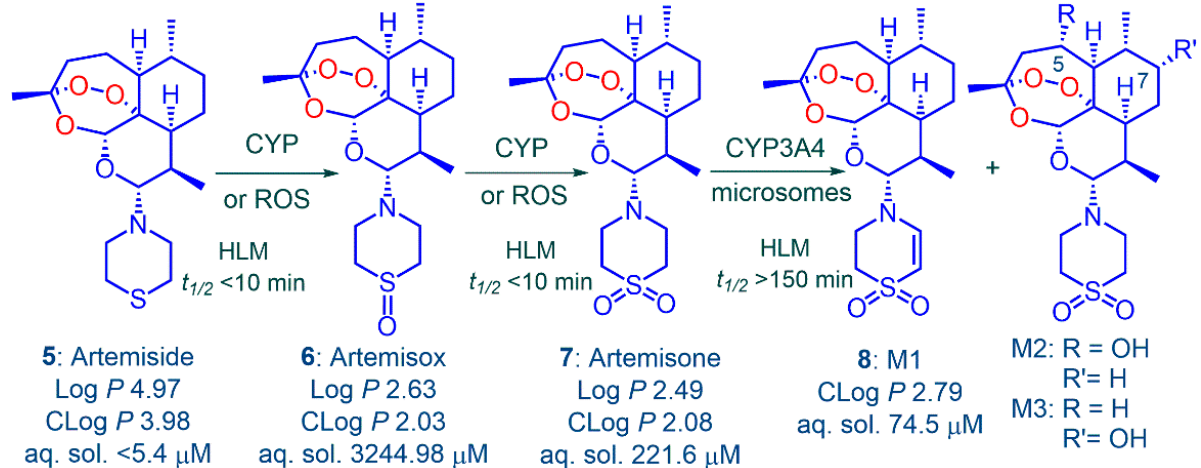
Figure 5. Metabolism of artemiside 5 via enzymatic or non-enzymatic oxidation to artemisox 6 and then to artemisone 7 . Human liver microsomal (HLM) half-lives t 1/2 for each of artemiside, artemisone, and M1 are given [25]. Artemisone is transformed by CYP3A4 into the metabolites M1 8 , M2, and M3 and smaller amounts of other metabolites [24,25,39]. Measured and calculated Log P values (ChemDraw V15.1) and aqueous solubility at pH 7.2 for compounds 5–7 are from [24]; aqueous solubility at pH 7.4 for metabolite M1 8 is from